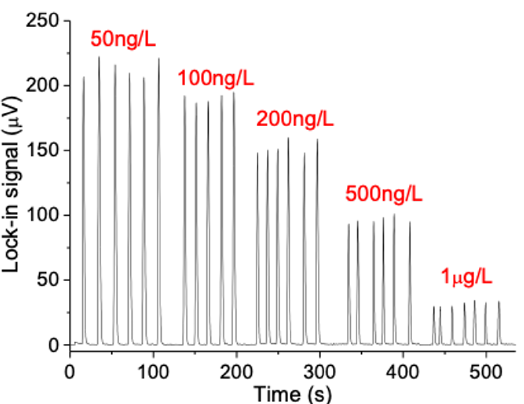
Figure 4. µ FIA-TLM signals recorded for replicate injections of microcystin-LR standard solutions Figure 4. µFIA − TLM signals recorded for replicate injections of microcystin − LR standard solutions (concentrations indicated above the peaks in (concentrations indicated above the peaks in red).